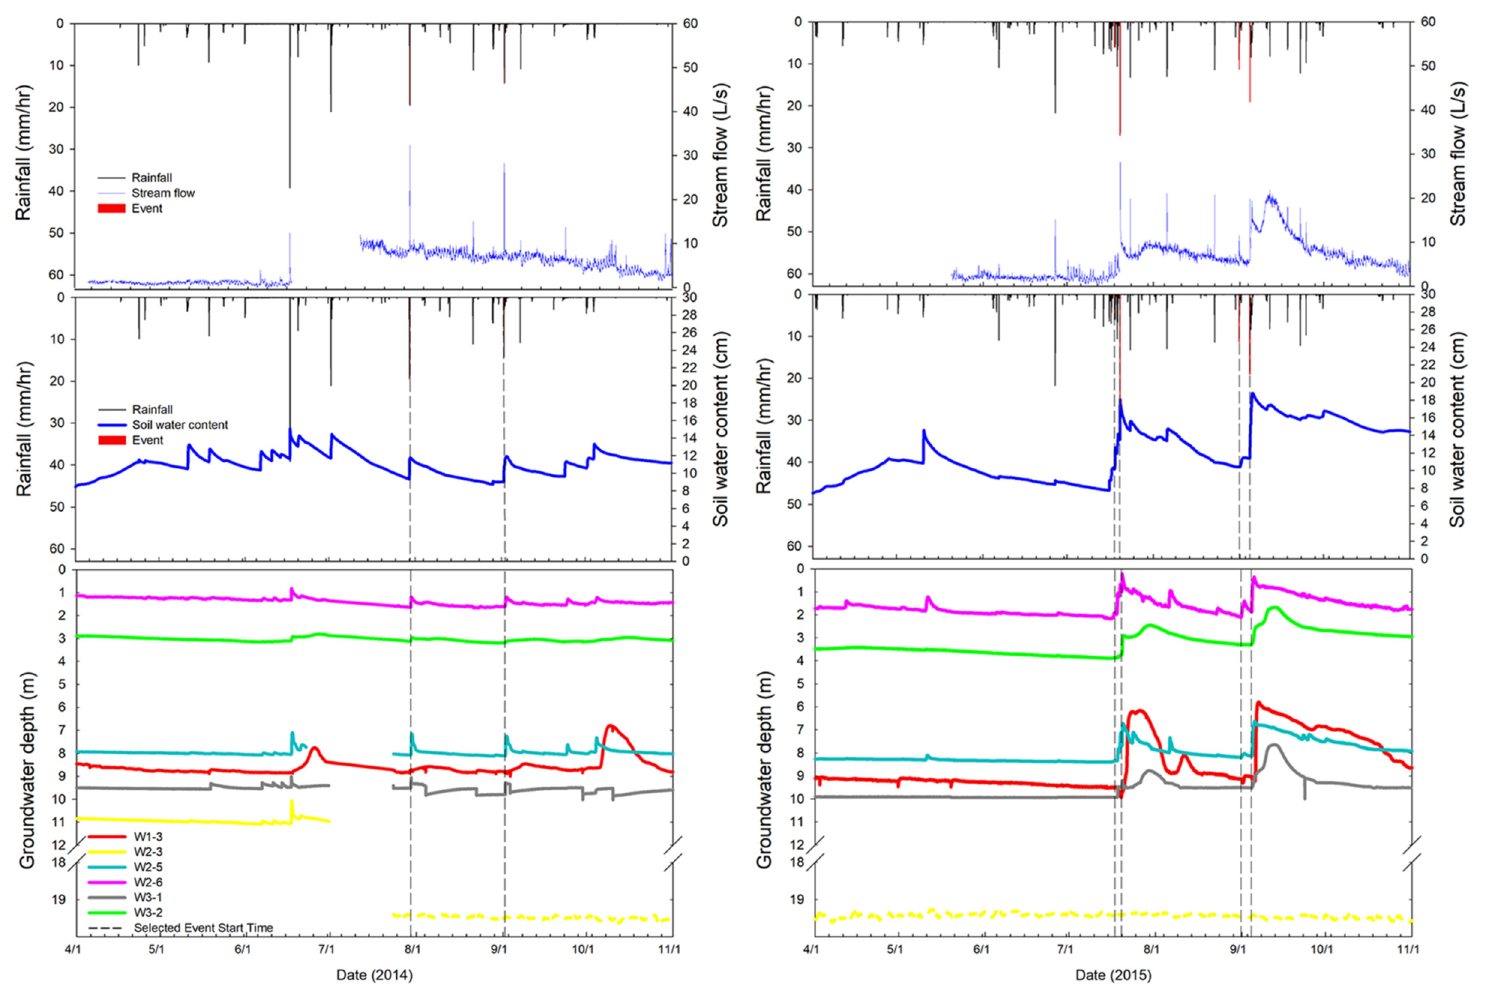
Figure 3. Rainfall (hourly), stream flow, soil water content at 80 cm depth and groundwater depth relative to soil surface from April 2014 to November 2015; 6 storm events are indicated with the gray dashed line on the hydrograph and the red highlight on rainfall.